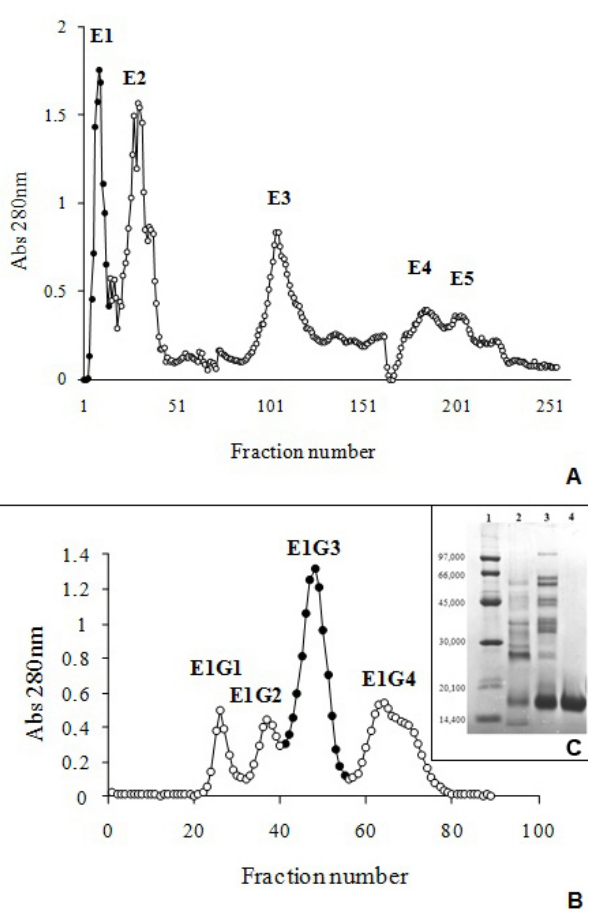
Figure 1. Purification of BmooMtx from Bothrops moojeni venom . (A) Separation on DEAE-Sephacel: crude venom from Bothrops moojeni (200 mg) was applied on the column (1.7 x 15 cm) and elution was carried out at a flow rate of 20 mL/hour with ammonium bicarbonate gradient buffer, pH 7.8, from 0.05 to 0.3 M. (B) Separation on Sephadex G-75: the active fraction (E1) was applied on the column (1.0 x 100 cm) and elution with 50 mM ammonium bicarbonate buffer at pH 7.8 was achieved at a flow rate of 20 mL/hour. Pooled fractions are indicated by the closed circle. (C) SDS-PAGE in 14 % (w/v) polyacrylamide, Tris-glycine buffer, pH 8.3, and 20 mA. Lines: (1) standard proteins; (2) crude venom of B. moojeni ; (3) E1; (4)